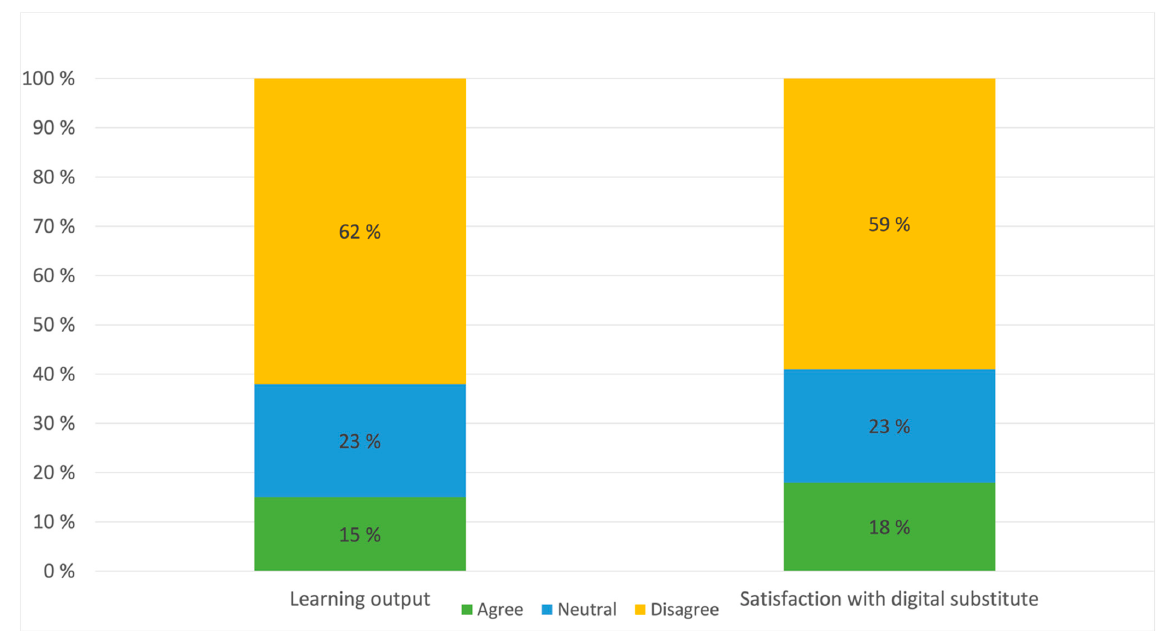
Figure 2. Distribution of agreement, disagreement, or neutral view on statements regarding clinical and practical education.